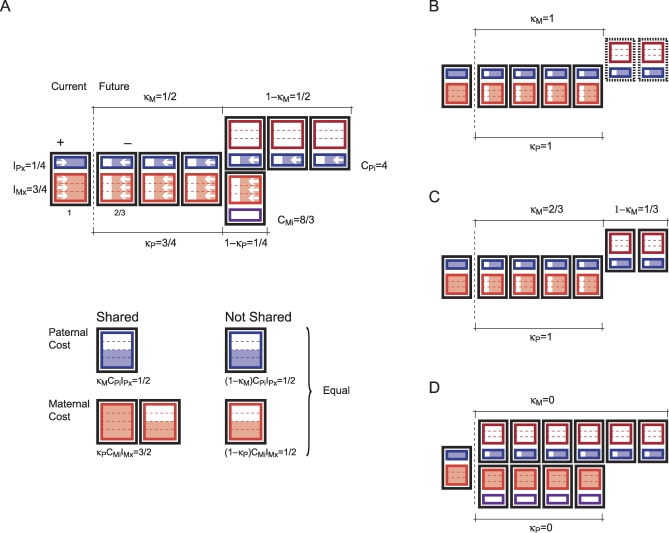
Mating System and Cost DistributionEach rectangle represents an offspring; the two rectangles contained in each offspring represent the parents—mother in red and father in blue—that produced the offspring and the fraction of resources contributed by each parent. The fraction of resources contributed by the mother is σ. The first rectangle corresponds to the current offspring and the following rectangles correspond to future offspring. If the future offspring is aligned with the current one—and carries the same color combination—then it has the same parents as the current offspring. If the future offspring is not aligned with the current one—and carries a different color combination—then it either has a different mother if it is above the current one or has a different father if it is below the current one. Any investment in the current offspring translates into a cost to the father and the mother in terms of residual reproductive value. In this example, the cost experienced by the father is also suffered by the mother with probability κP and the cost experienced by the mother is also suffered by the father with probability κM. The cost of providing an additional unit of investment is different for the father CPi and the mother CMi. In case A, mothers contribute more than fathers, σ = ¾, the maternal costs shared by the father affects to κM = ½ of the father's residual reproductive value, the paternal cost shared by the mother affects κP = ¾ of the mother's residual reproductive value. The paternal cost for each unit of investment is almost two times the maternal cost. In this scenario, the paternal cost not shared with the mother is equal to the maternal cost not shared with the father. In case B, there is lifetime monogamy and when the mother dies, the father does not produce any more offspring even if he had resources to do so. In case C, there is sequential monogamy and when the mother dies, the father finds a new mate. In case D, father and mother change partners to produce every single offspring.